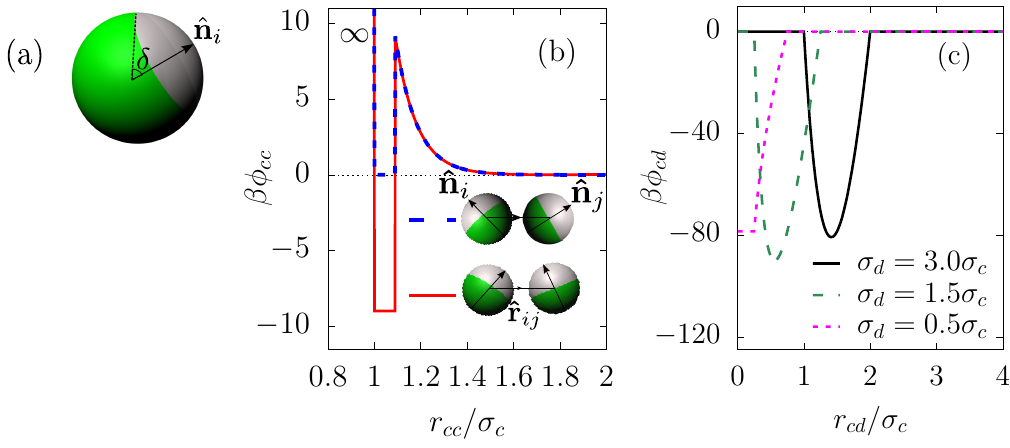
Figure 1. Pair potentials for the binary mixture of patchy colloids and droplets. ( a ) illustration of a single patchy colloid i with orientation ˆ n i and opening angle δ of the attractive patch (white); ( b ) potentials between two colloids with κσ c = 10, β(cid:101) Y = 24.6, β(cid:101) SW = 9, ∆ = 0.09 σ c β = 1/ k B T . Shown in the legend is the Janus case χ = 1/2. When the attractive parts of two particles properly face each other, they interact via the square-well potential of depth 18 k B T (red solid line), and otherwise they interact via the square-well potential of depth 9 k B T (blue dashed line); ( c ) colloid–droplet potential at σ d ( t ) / σ c = 3, 1.5 and